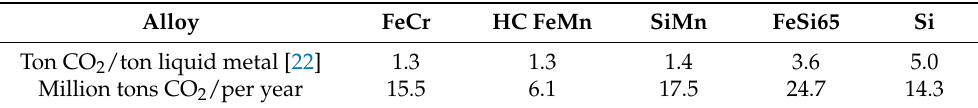
Table 2. Exemplary generic CO 2 emissions for the production of ferroalloys per metric ton of liquid alloy and the total emissions for 2016, excluding the